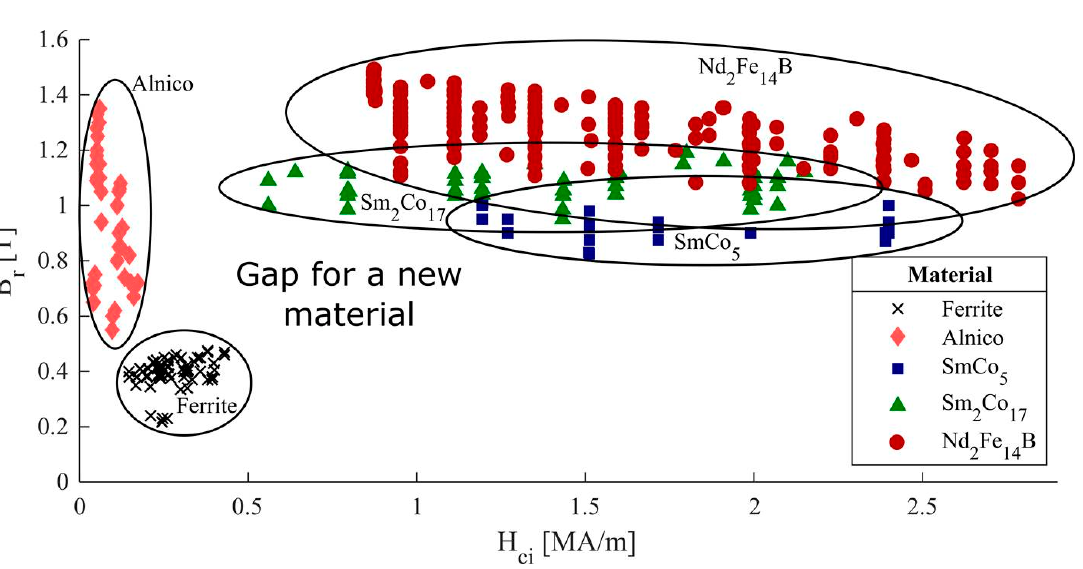
Figure 1. Different PM materials available on the market and their properties, illustrating the gap between ferrites and rare-earth (RE) magnets.